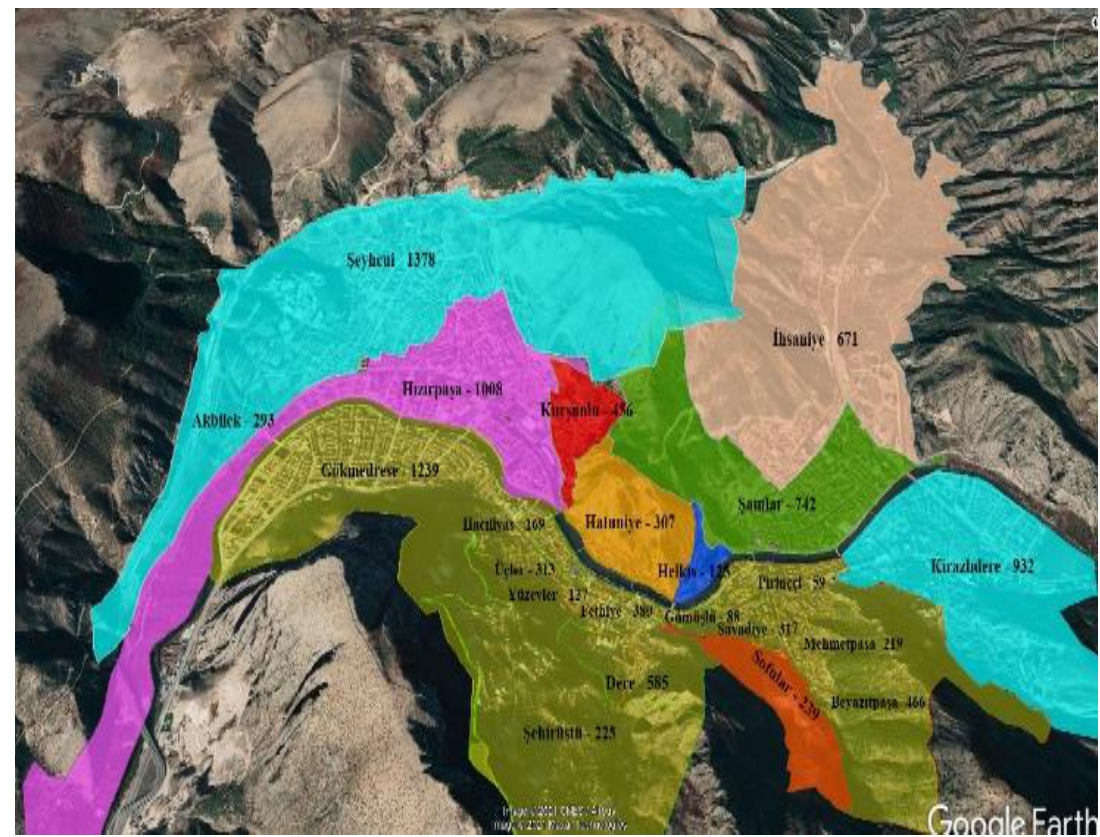
Figure 5. Working